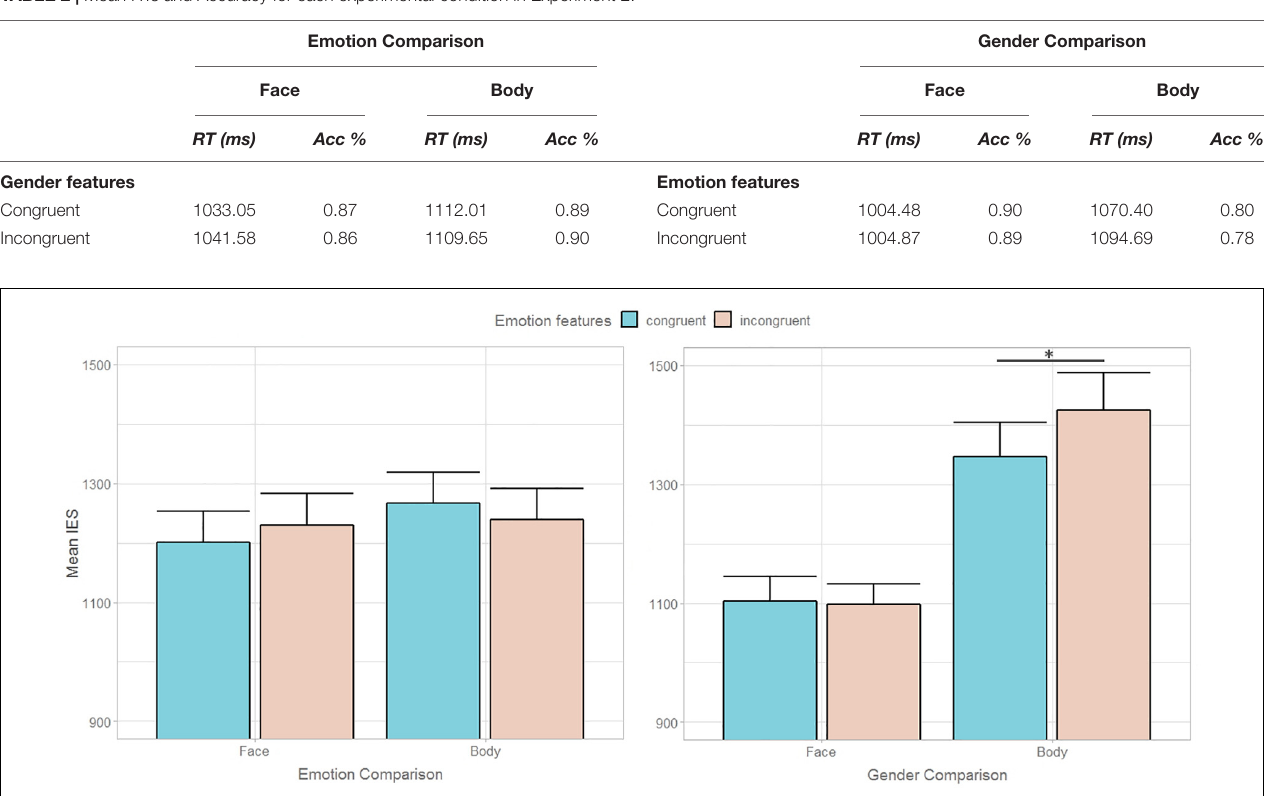
FIGURE 3 | Mean inverse efficiency scores (IES) during Emotion and Gender comparison according to task-relevant (left graph) and task-irrelevant (right graph) emotional congruency between central and lateral stimuli in Experiment 2. Error bars represent + 1